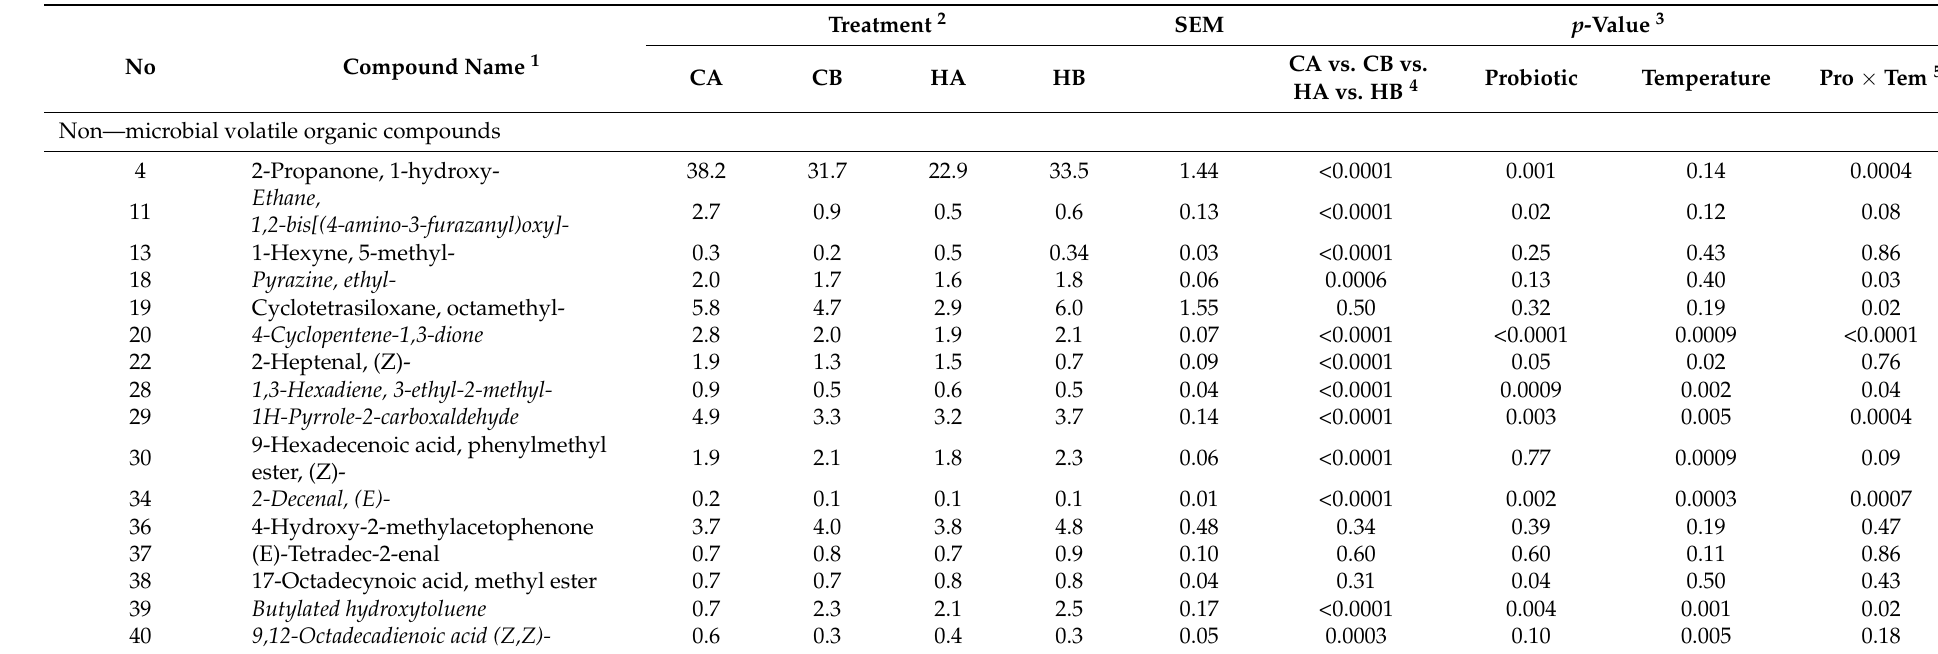
Table 3. Volatile organic compounds, listed in order of retention time, of the pelleted treatments measured by the Gas chromatography/Mass spectrometry.